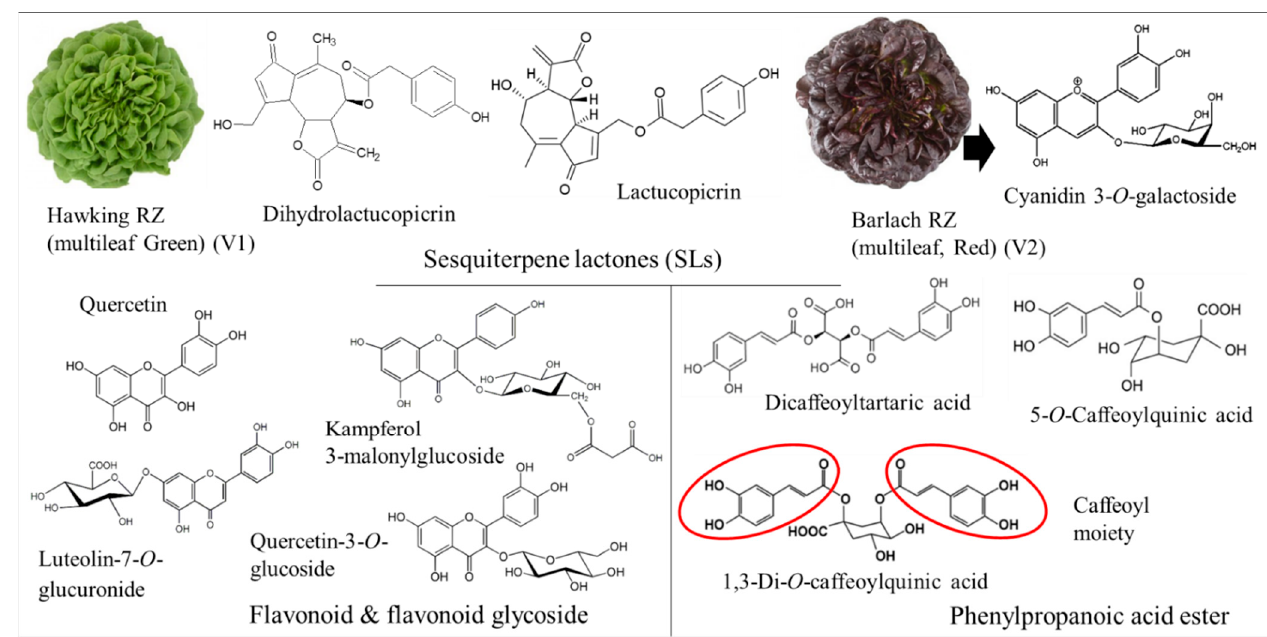
Figure 1. Some secondary metabolites produced by green and red multi-leaf lettuce.